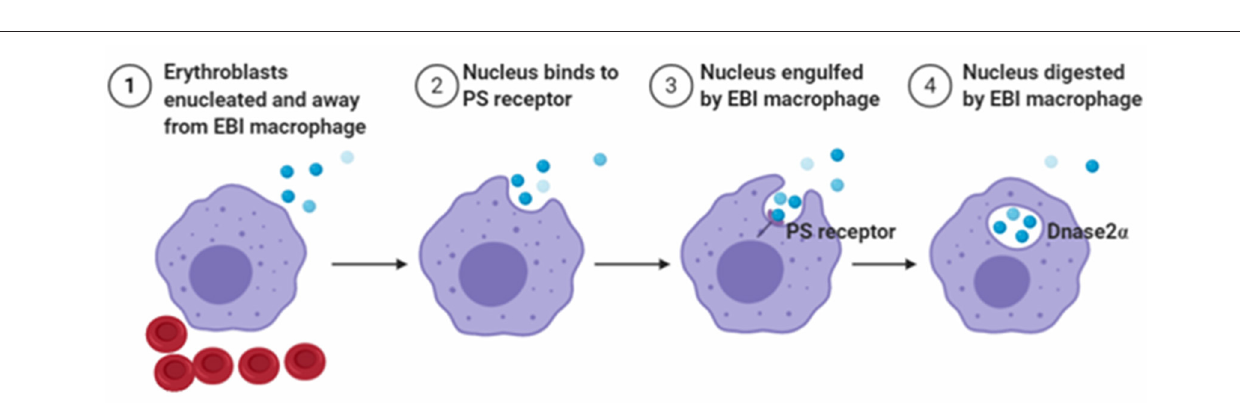
Frontiers in Cell and Developmental Biology |